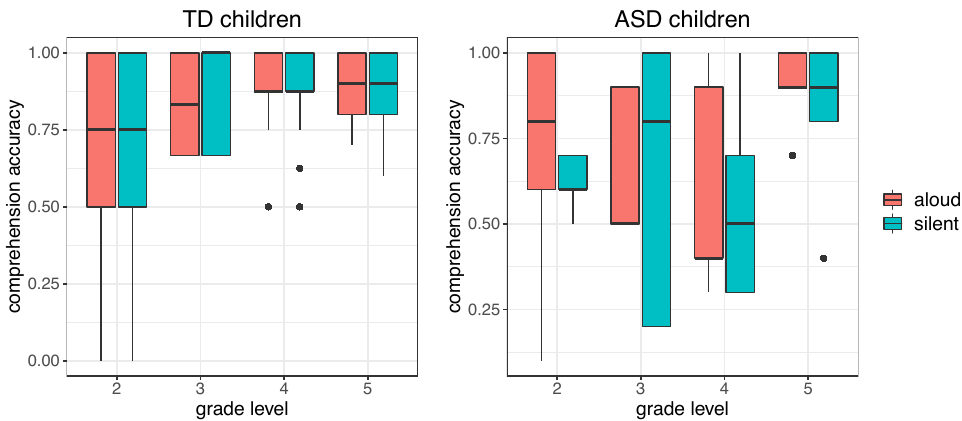
Figure 8. Boxplot distributions of accuracy scores (normalized in a 0–1 range) for aloud and silent reading in TD and ASD children for the four grade levels (from 2nd to